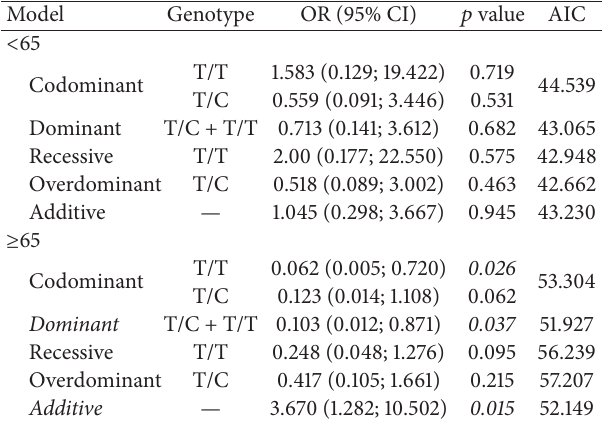
Table 10: Binomial logistic regression analysis of the CYP4F2 (1347C > T; V433M) rs2108622 in the males with eAMD and in the control group by